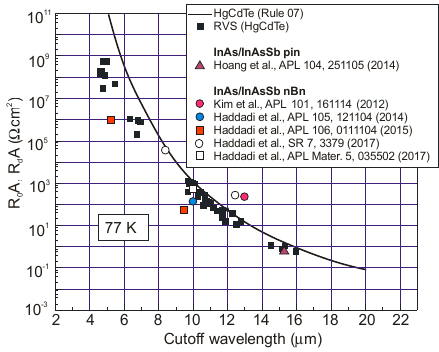
Figure 54. R o A and R d A product of nonbarrier and barrier T2SL InAs/InAsSb detectors on λ cut-off wavelength dependence compared to experimental data and trend line (“Rule 07”) for HgCdTe photodiodes at 77 K. The experimental data for InAs/InAsSb SLs devices are taken from [163–168].